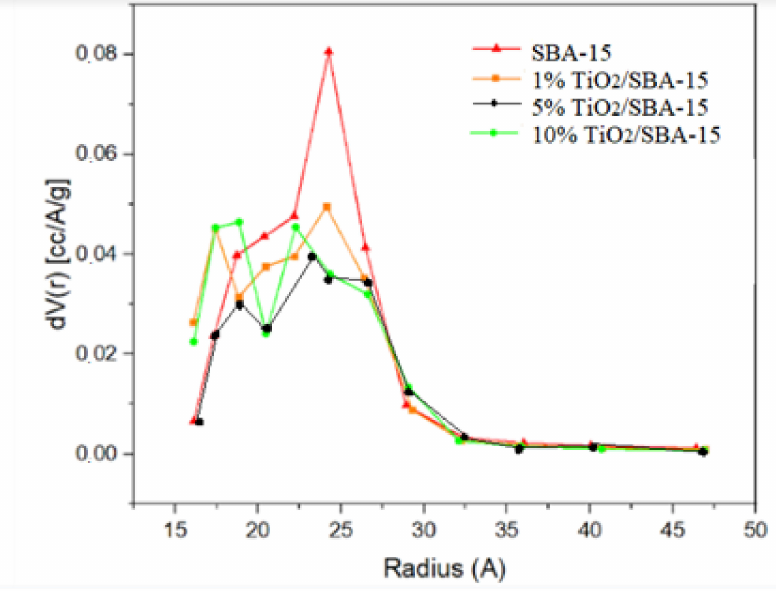
Figure 5. Pore size distribution by BJH